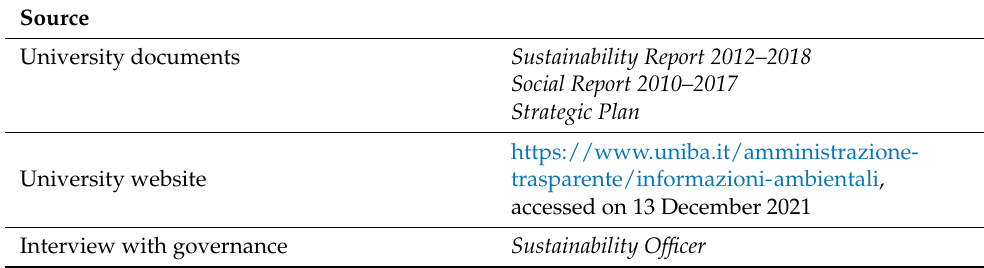
Table 1. Source used for the case